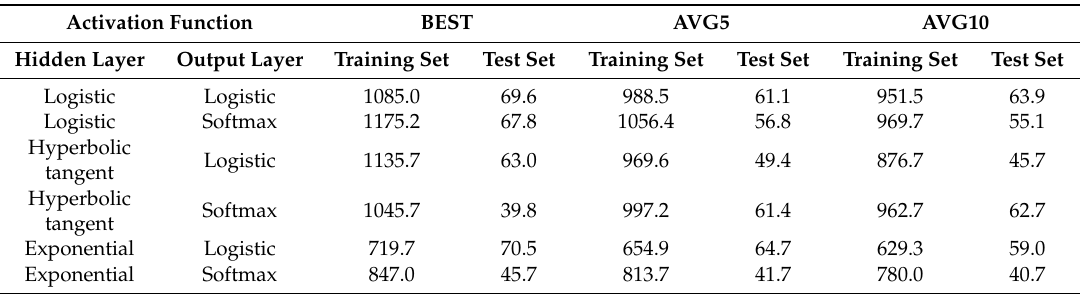
Table 6. Results (in USD/b) obtained in the SANN with a division into activation functions used in the hidden layer and in the output layer.